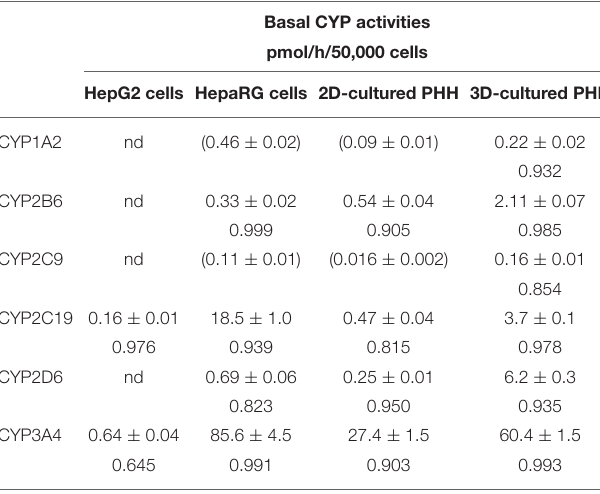
TABLE 2 | Basal CYP